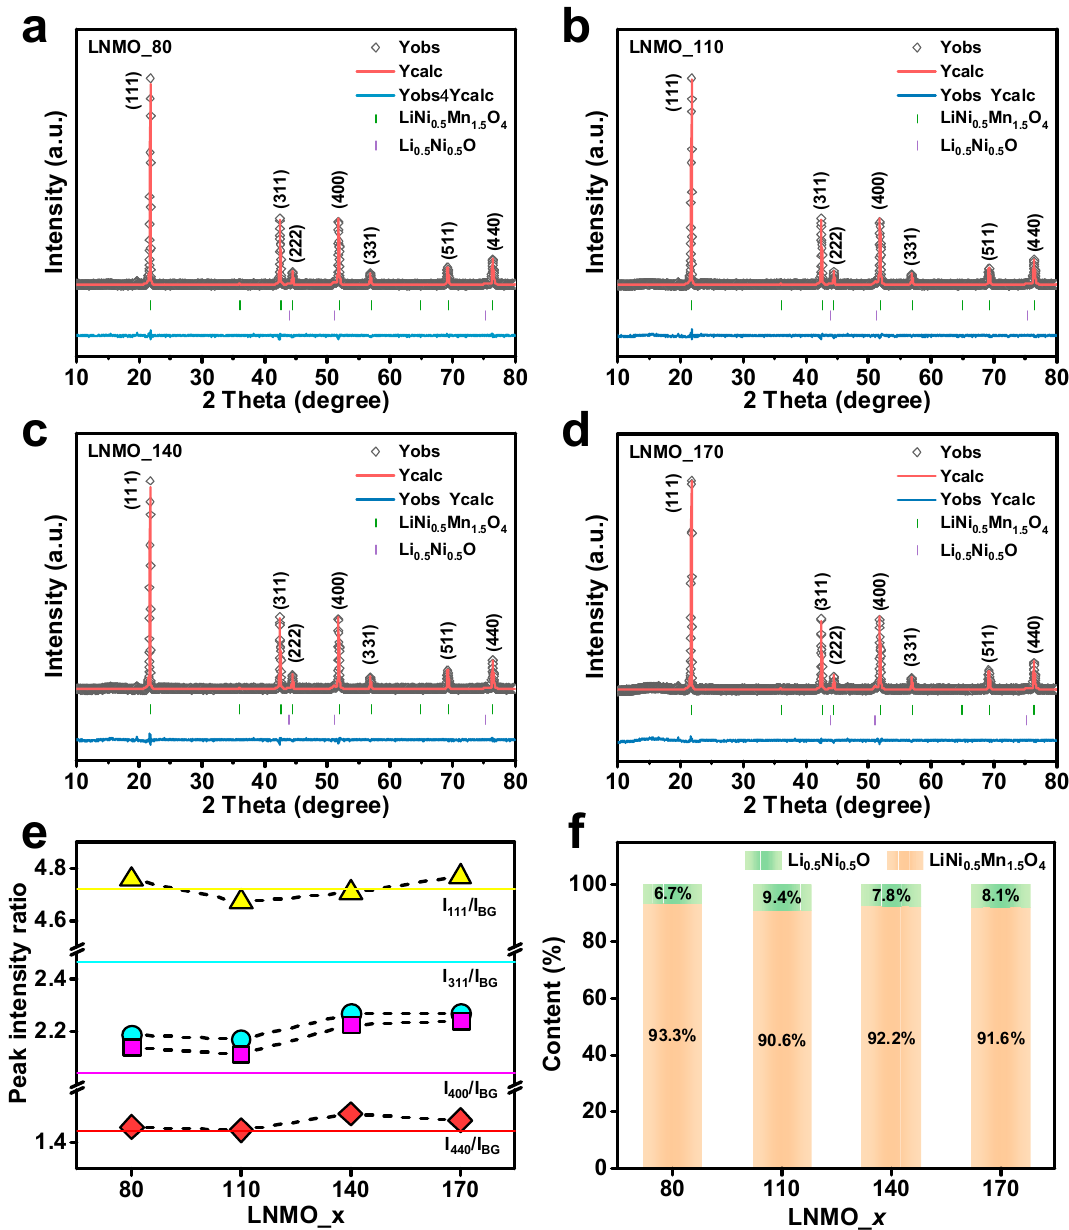
Figure 3. ( a – d ) XRD patterns and Rietveld refinement comparison of LNMO_ x samples. Bragg positions of the LiNi 0.5 Mn 1.5 O 4 phase and Li 0.2 Ni 0.8 O phase are shown with vertical bars. ( e ) Peak intensity ratios of (111), (311), (400), and (440) peaks to the mean intensity of the background. The corresponding horizontal line is the expected value from the PDF standard card of pure LNMO. ( f ) Quantitative analysis from pro fi le- fi tt ed peaks by RIR method.